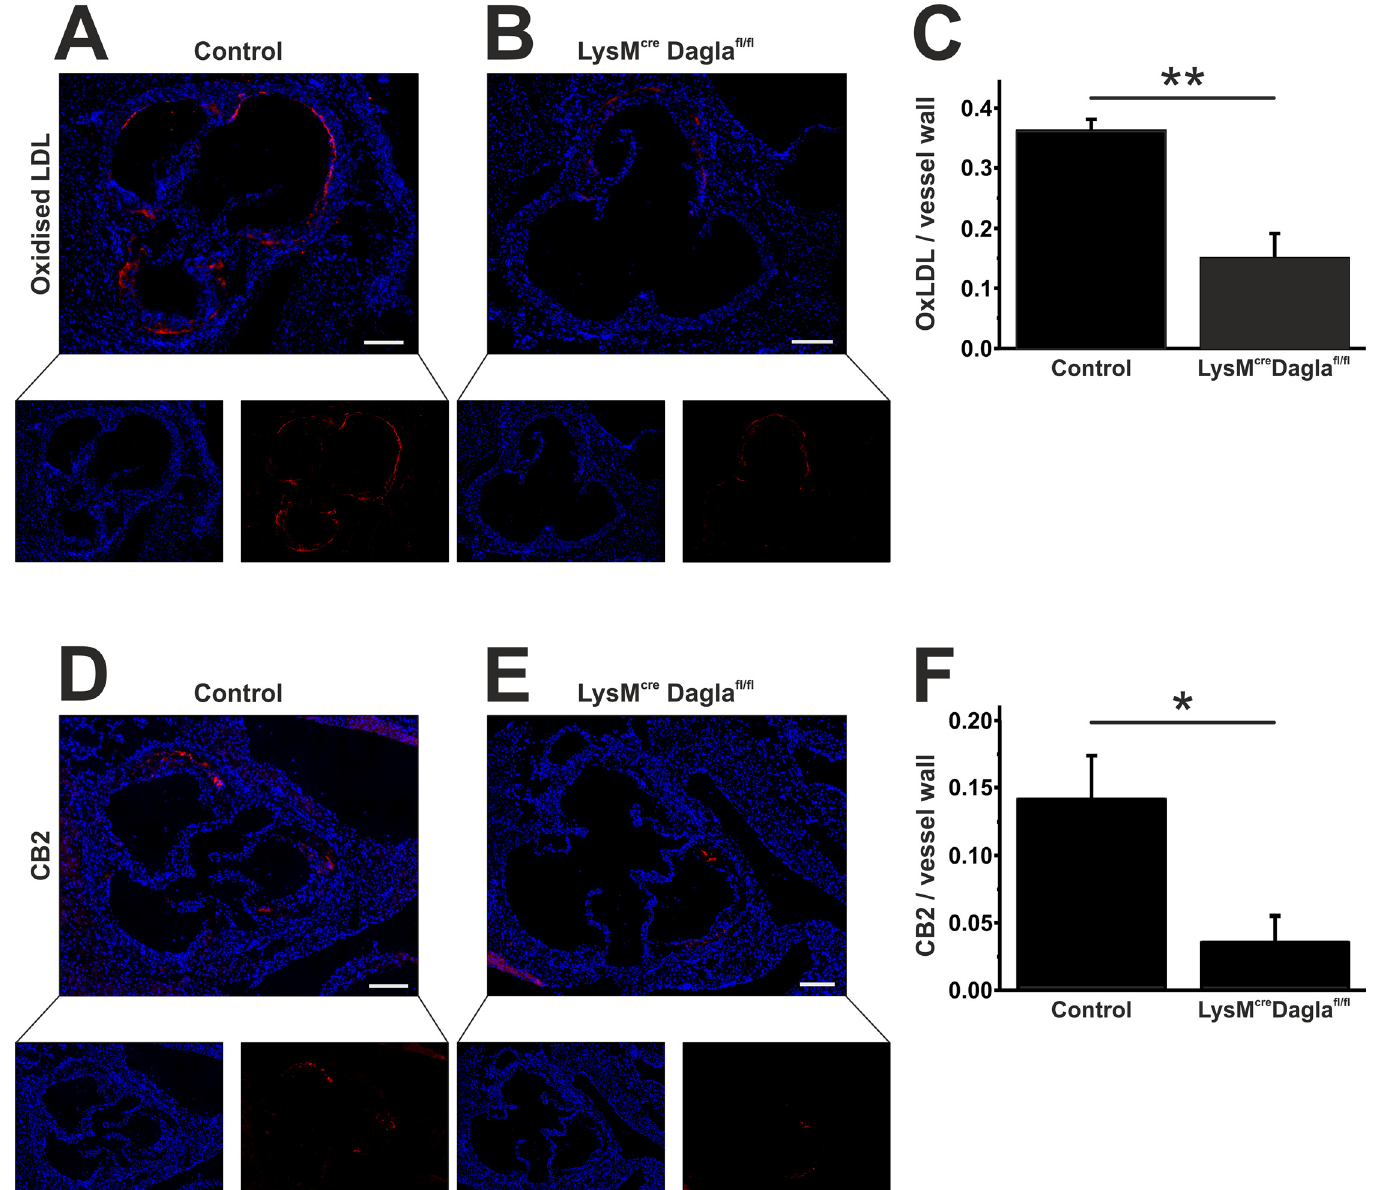
Fig 3. Assessment of oxLDL and CB2 within atherosclerotic lesions. Frozen sections through the aortic sinus of both control mice and Dagla-deficient mice were stained for oxLDL. OxLDL formation was predominant in the endothelium and within atherosclerotic plaques (A, B). OxLDL formation was significantly diminished in Dagla-deficient mice (C). Staining for CB2 revealed a significantly reduced CB2 expression within the aortic sinus (D-F). Data are presented as mean ± standard error of the mean; n = 3 – 5; * , p < 0.05; ** , p < 0.01. Scale bar, 200 μ m. CB2, cannabinoid receptor 2; Cre, cyclisation recombination; Dagla, diacylglycerol lipase α ; fl, flanked by loxP; LDL, low-density lipoprotein; LysM, lysozyme 2